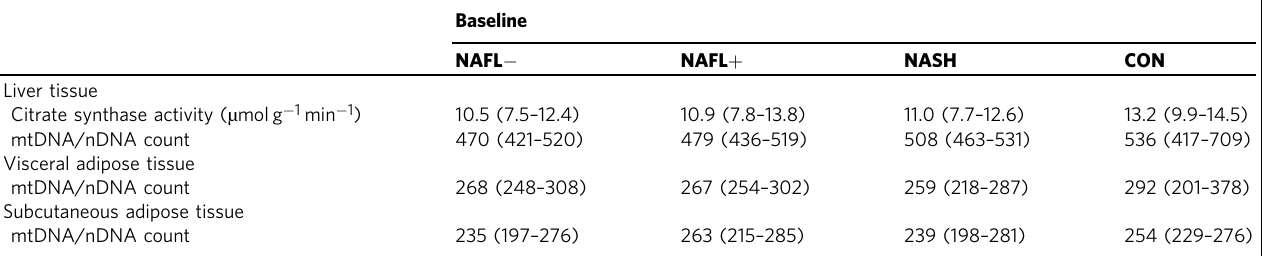
Table 2 Citrate synthase activity and mtDNA/nDNA count in liver-, visceral adipose- and subcutaneous adipose